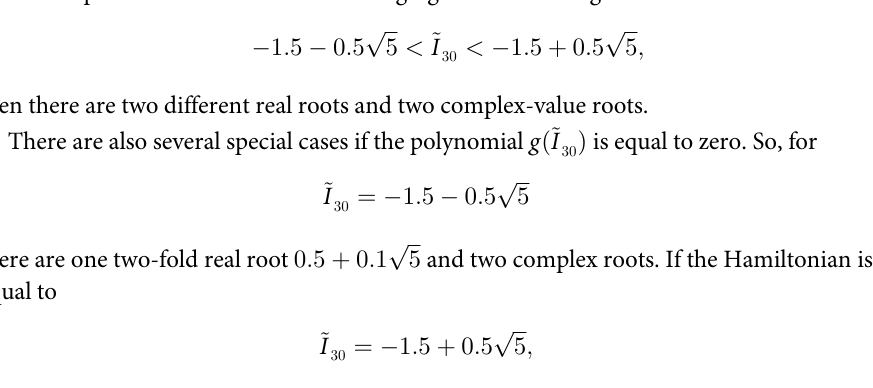
ffiffiffi p 5 ; 0 Þ —one multiple real root and two complex roots. Dependence of the roots on the incident LFW intensity at —blue solid line, P —red dashed-dotted line, P —green line with triangles, P —yellow line with 1 1 1 2 1 3 1 4